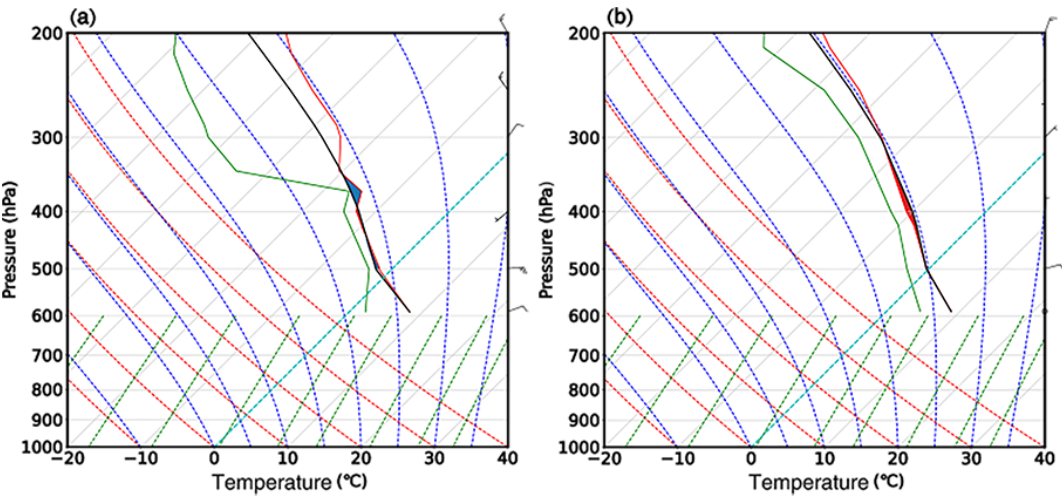
Figure 2. T -log P sounding data from Naqu station at (a) 00:00 and (b) 12:00UTC on 24 July 2014 (solid black line: temperature–pressure curve (laminar curve); solid green line: dew point pressure curve; solid red line: state curve; solid gray line (diagonal): isotherm; solid gray line (horizontal): isobaric line; dashed blue line: adiabatic wet line; dashed red line: adiabatic dry line; dashed green line: saturation mixing ratio; and dashed light blue line: 0 ◦ C isotherm).